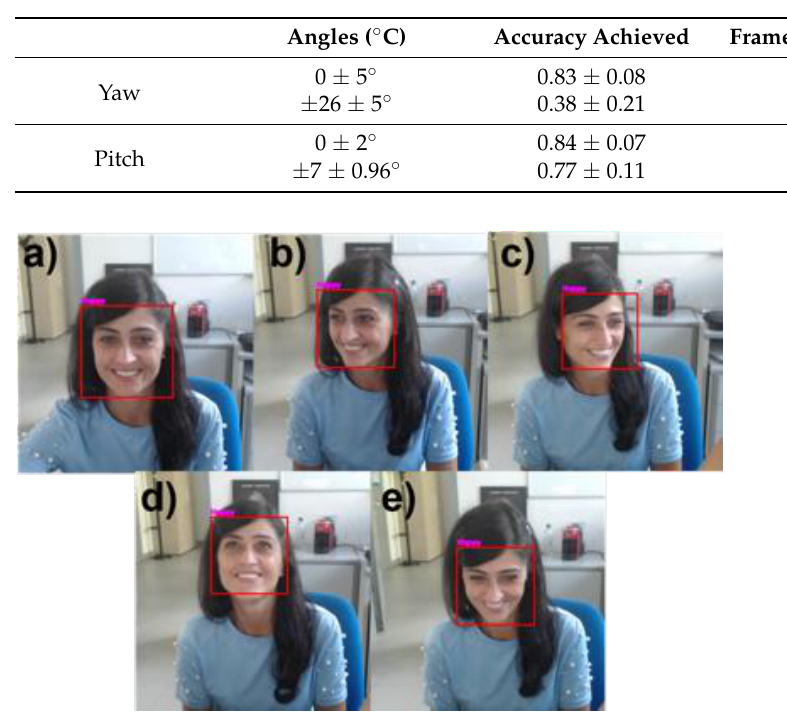
Figure 13. Pictures of a representative participant exhibiting happy facial expressions to the NAO robot in ( a ) frontal; ( b , c ) yaw; and ( d , e ) pitch orientations. The red rectangle represents the detected face, and the writing above the rectangle reflects the facial expression recognized by NAO through the integrated